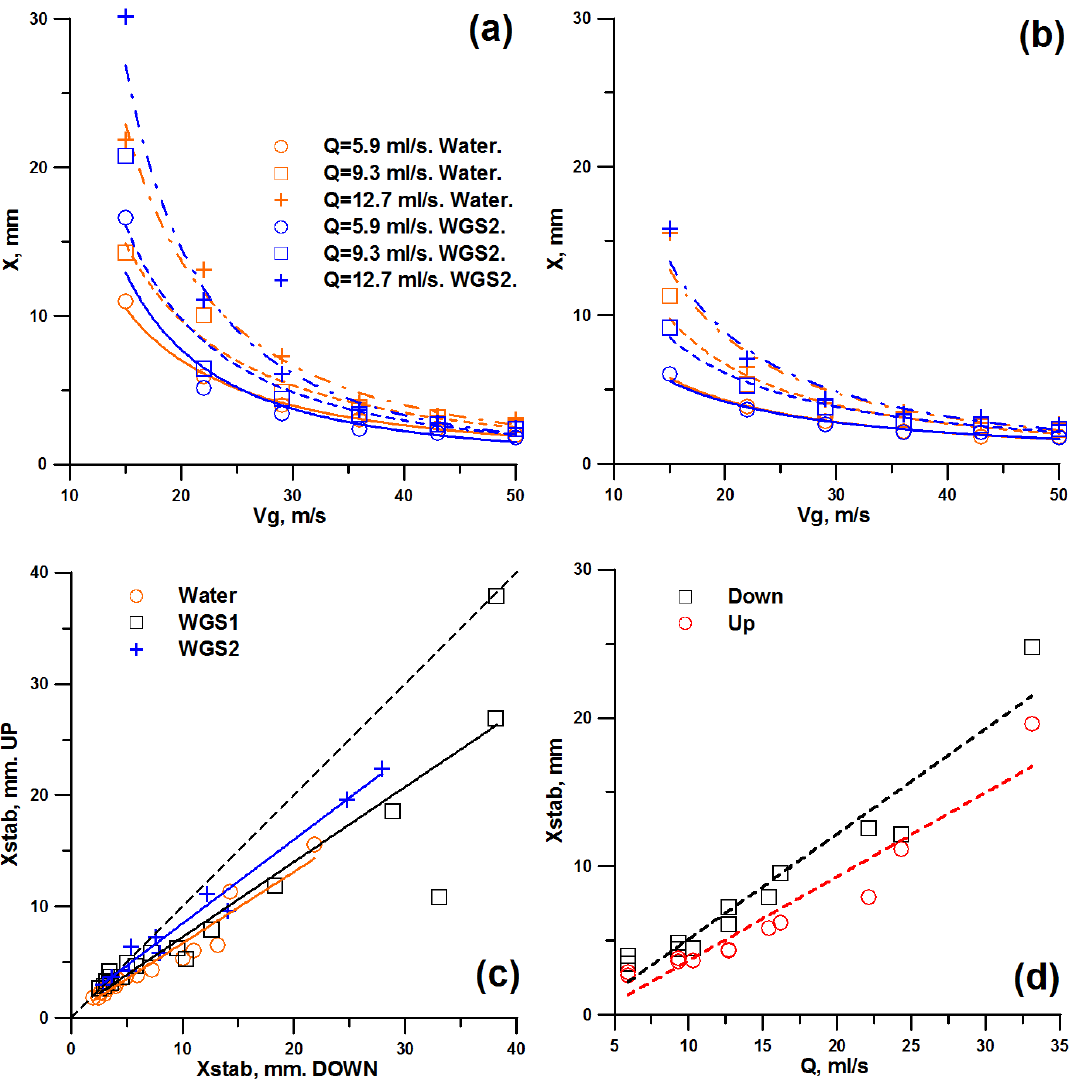
Figure 4. Length of the stabilization zone. ( a , b ) The effect of liquid viscosity at a fixed liquid flow rate for downward ( a ) and upward ( b ) flows. ( c ) The effect of flow orientation. ( d ) The effect of the liquid flow rate for a fixed gas velocity, V G = 29 m/s.